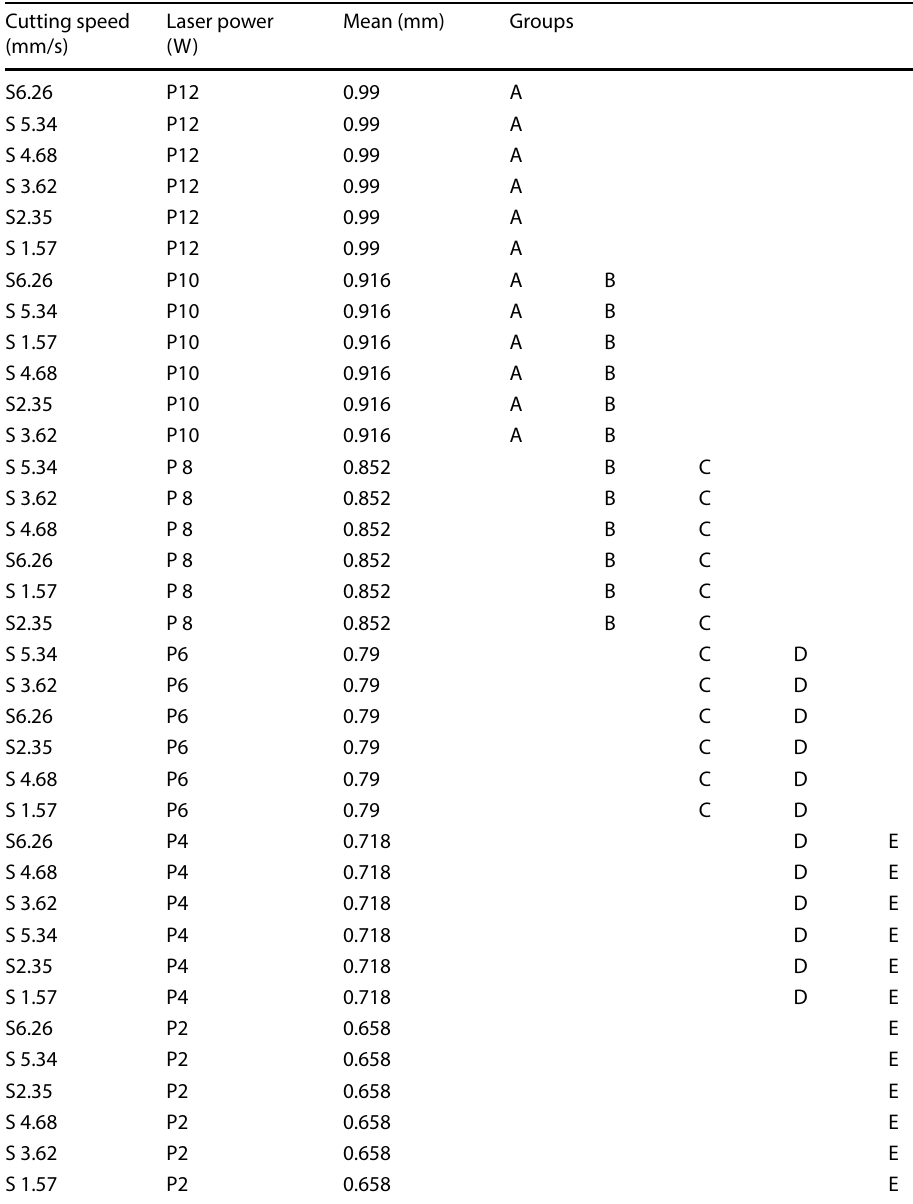
Table 27 Cutting speed & laser power